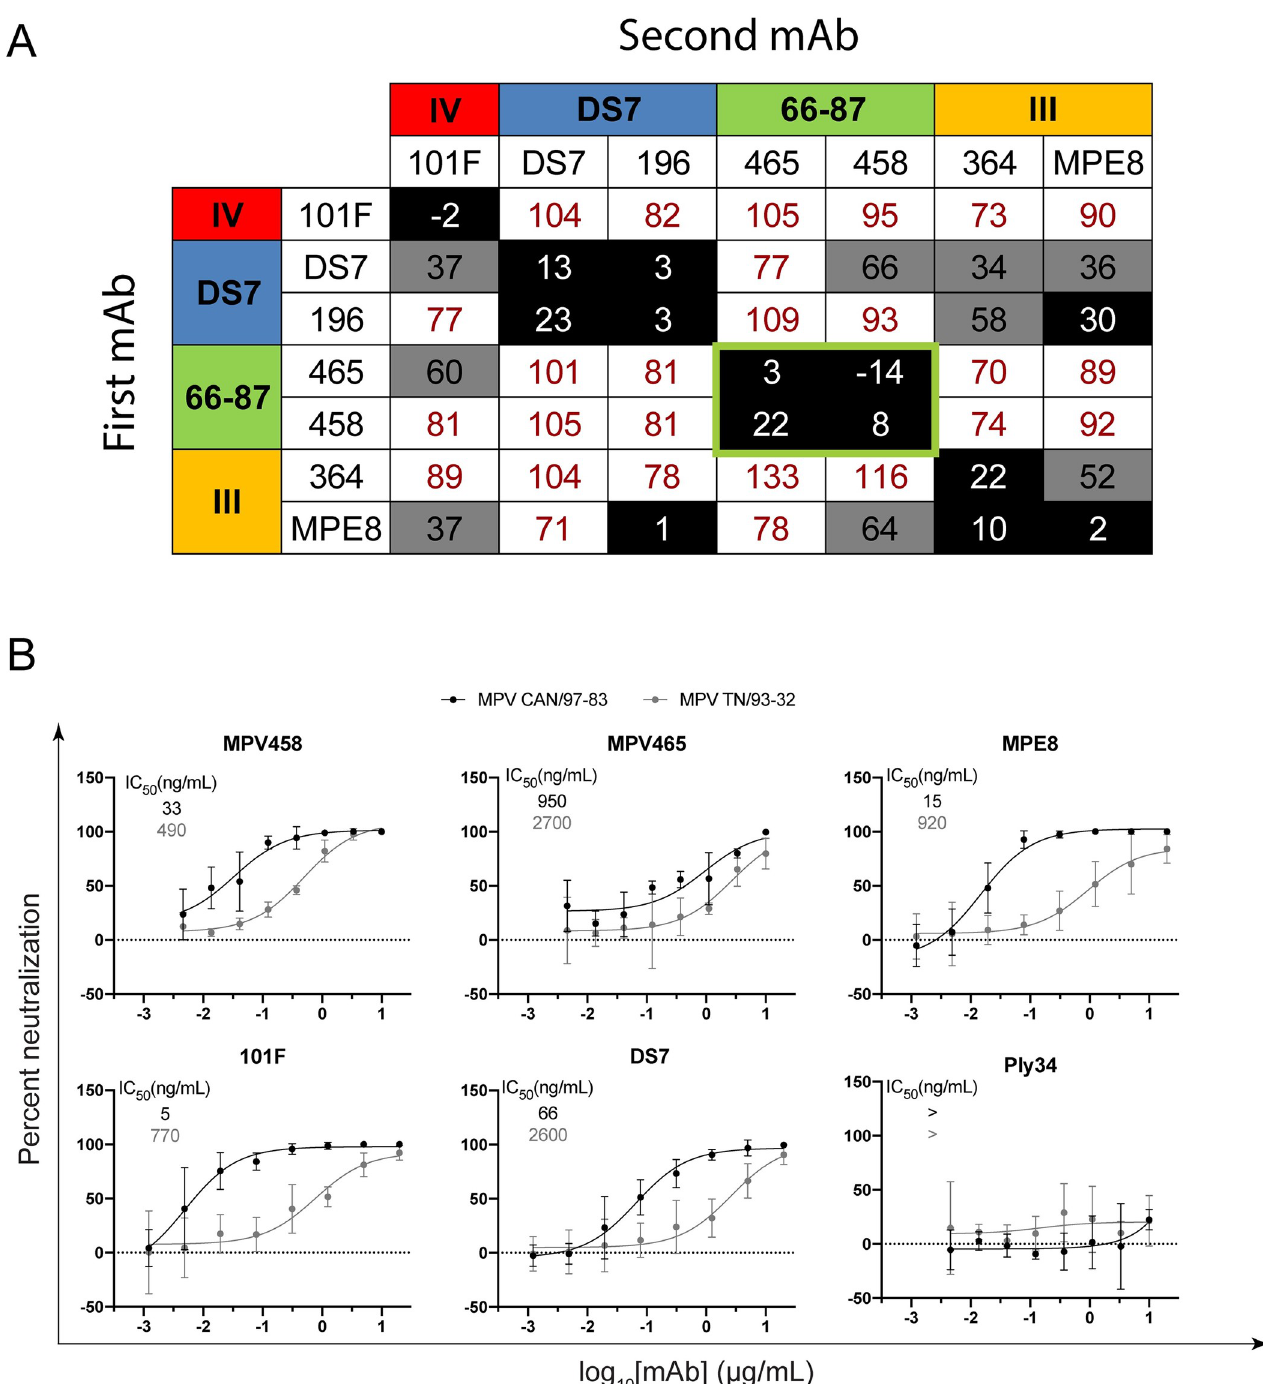
Fig 1. Epitope specificity and neutralizing properties of MPV458 and MPV465. (A) Epitope mapping of the hMPV F-specific mAb panel. Epitope control mAbs include 101F (site IV), DS7 and MPV196 (DS7 epitope), and MPV364 and MPE8 (site III). MPV465 and MPV458 do not compete with known mAbs, and compete with each other for binding, suggesting both mAbs bind at a previously undiscovered antigenic site. Data indicate the percent binding of the competing antibody in the presence of the primary antibody, compared with the competing antibody alone. Cells filled in black indicate full competition, in which � 33% of the uncompeted signal was observed; cells in gray indicate intermediate competition, in which the signal was between 33% and 66%; and cells in white indicate noncompetition, where the signal was � 66%. Antigenic sites are highlighted at the top and side based on competition binding with the control mAbs. (B) Plaque neutralization curves for MPV458 and MPV465 with controls. Both MPV458 and MPV465 are neutralizing, while MPV458 has neutralizing properties similar to MPE8 and 101F. IC 50 values are inlaid in each curve. The pneumococcal-specific antibody Ply34 was used as a negative